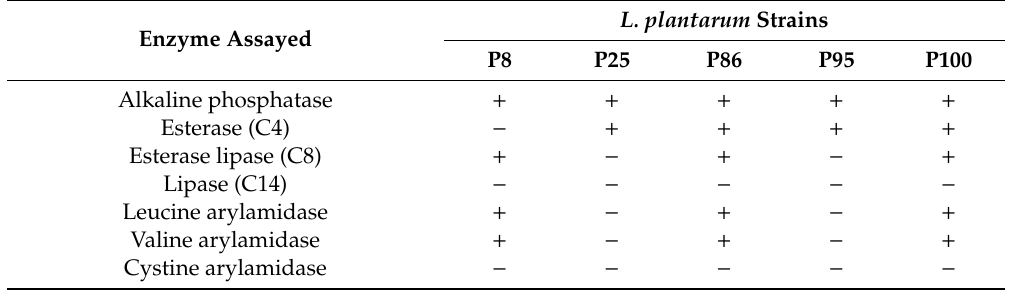
Table 2. Enzymatic profile of the five L. plantarum strains performed using API-ZYM system (BioM è rieux). + positive; −